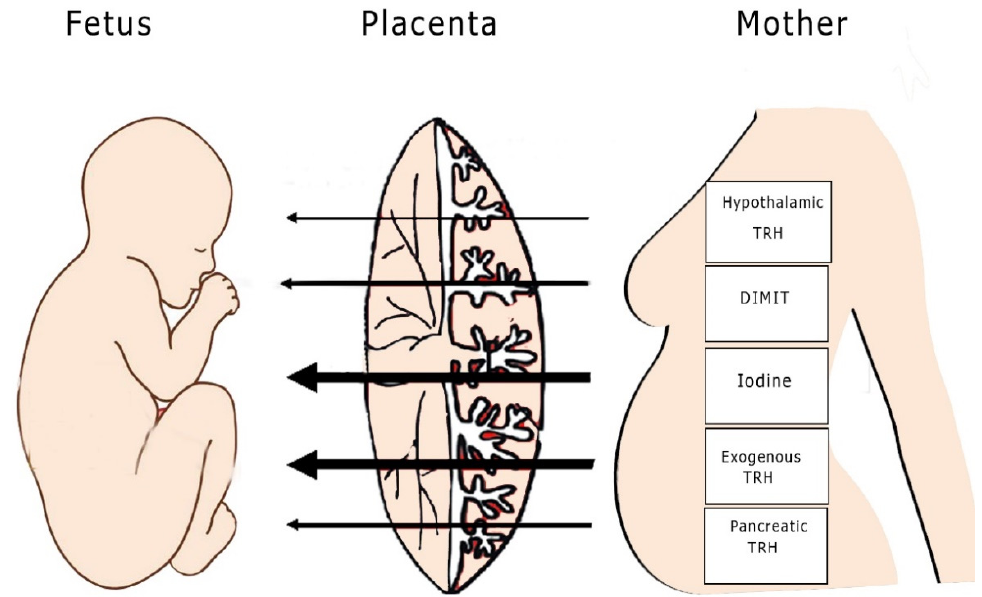
Figure 1. Penetrability of thyroid hormones. The thickness of the arrows reflects the level of penetrability of each element (TRH: thyrotropin-releasing hormone; DIMIT: 3 ′ ,5 ′ -dimethyl,5-isopropyl thyronine).